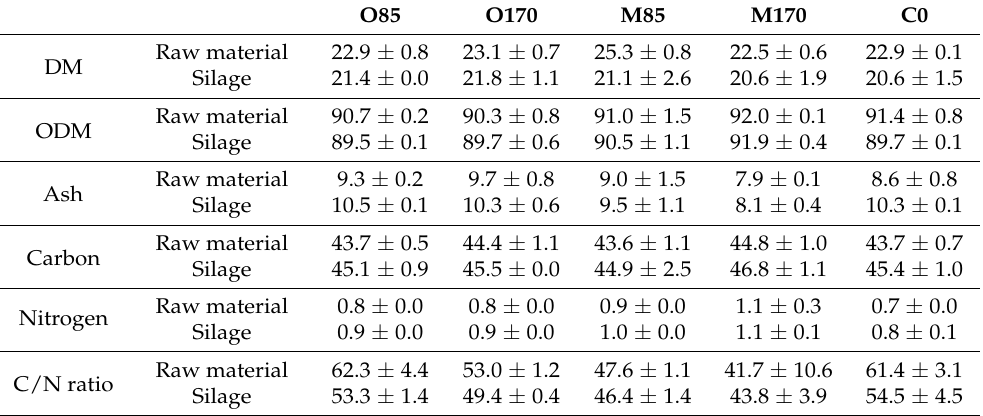
Table 3. Characteristics of raw material and silage of Silphium perfoliatum used for the preparation of feed- stock. (O85—organic fertilization 85 kg ha − 1 N; O170—organic fertilization 170 kg ha − 1 N; M85—mineral